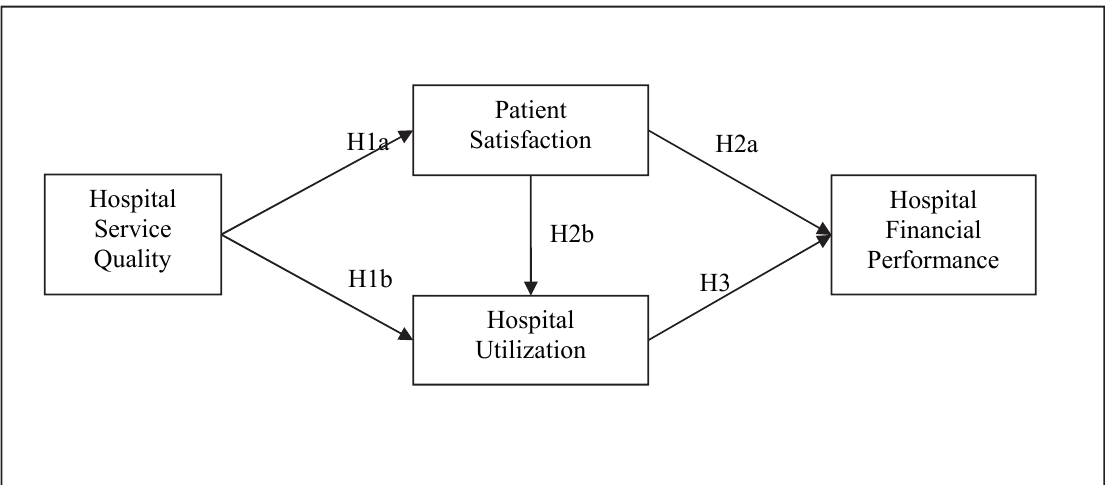
Fig. 1. Conceptual Model and Research